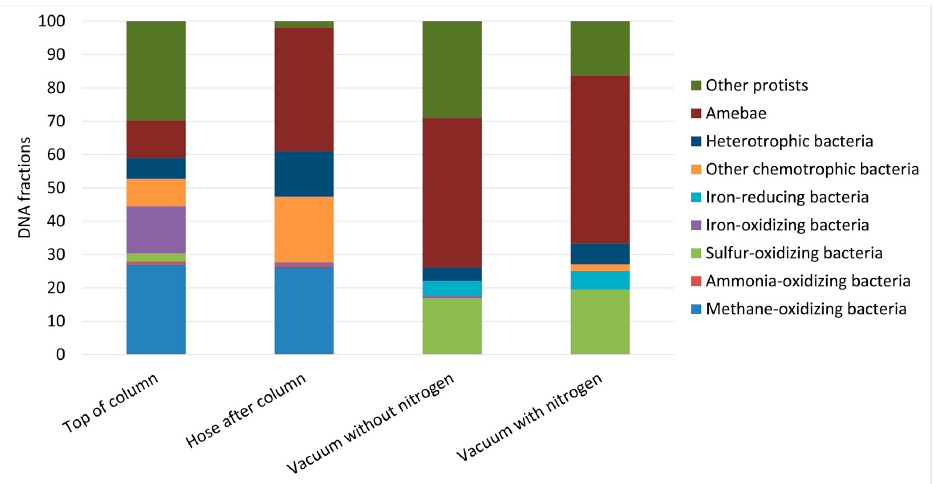
Figure 4. Fractions of DNA from organisms in samples from three pilot studies. Eukaryotes consist of amebae and other protists while prokaryotes are bacteria categorized on the basis of their metabolism. “Top of column” is a sample of water with visible growth. “Hose after column” is biomass from clogged hose. Both samples were collected in the study with groundwater with methane. “Vacuum without nitrogen” was analysed in loose deposits in a hose after 1 month study. “Vacuum with nitrogen” was analysed in loose deposits in a hose after 1 month study.